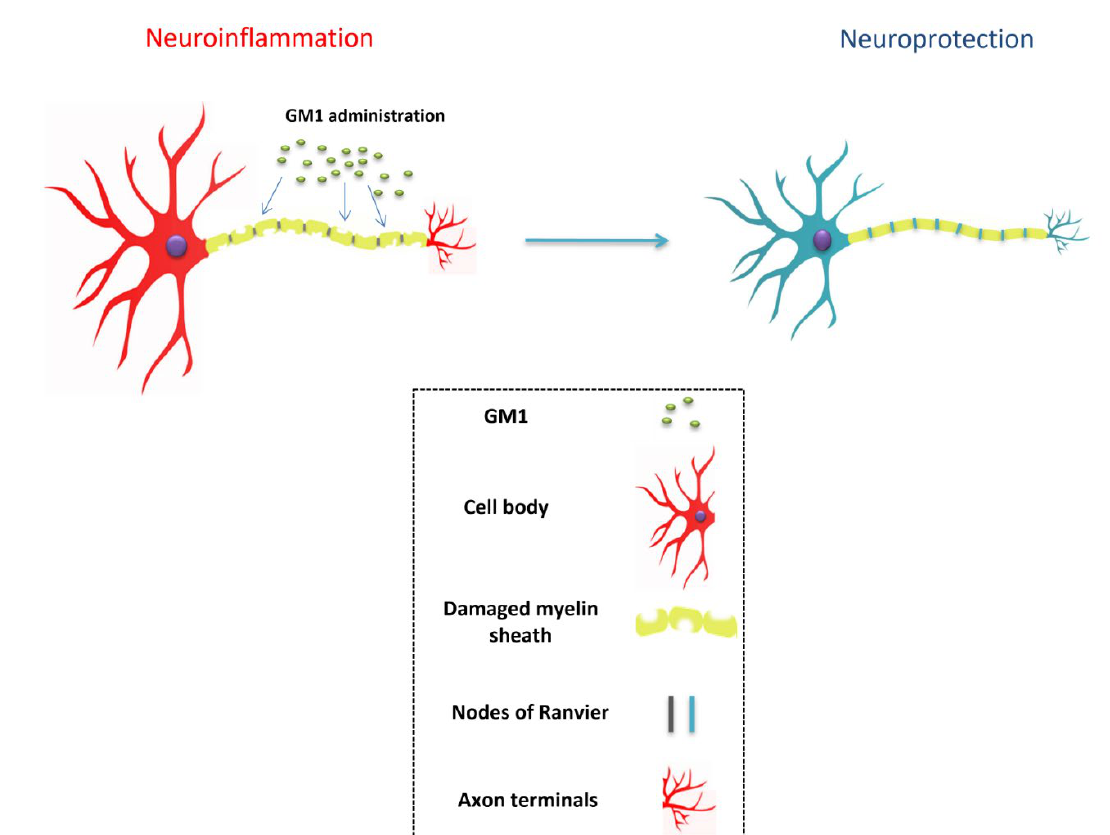
Figure 2. Sygen mediates neuronal stabilization. Gangliosides are further involved in the organization of nodes and paranodes in myelinated fibers. They assist in the compartmentalization of adhesion molecules such as neurofascin-155 and contactin/caspr1 in order to establish the adequate cytoarchitecture of paranodal regions [70]. Another essential function is the compartmentalization of Kv (voltage-gated potassium channels) channels and anchor proteins contactin-associated protein-like 2 (CASPR2) and transient-axonal glycoprotein 1 (TAG-1) in juxtaparanodal regions [70]. In mice studies, for example, the deletion of B4GALNT1 gene gives rise to the mislocalization of sodium and potassium channels and disorganization of paranodes and nodes of Ranvier [70]. In the PNS, myelin gangliosides work synergistically with axonal gangliosides in order to maintain paranodal and juxtaparanodal regions organized [74]. Collectively, these roles are of extreme importance. Dysfunctions in the nodes of Ranvier have been demonstrated to be major contributors to the pathophysiological pro- gression of various neurological disorders. The high density of voltage-gated sodium channels (Nav) in the excitable nodal axolemma is required for the proper conduction of action potentials [75]. Neuronal damage of any nature alters the localization and expression of ion channels, thus impairing axon–glial interactions [75]. Chronic nerve compression, for instance, can damage paranodal junctions and axonal domains, which are essential for adequate conduction of action potentials along myelinated axons [76]. Lastly, mislocaliza- tion and impaired function of the Kv channels, in particular, have also been associated with neuropathic pain [76]. Therefore, the exogenous administration of GM1 may at least avoid significant dysfunction of peripheral nerves and assist in the management of neuropathic progression (Figure